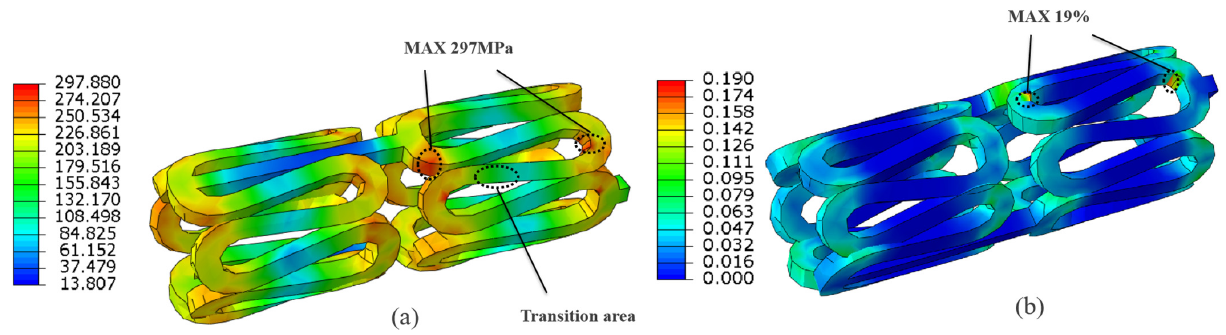
Figure 6. The equivalent stress ( a ) and equivalent strain ( b ) distribution clouds for the stent after crimping.